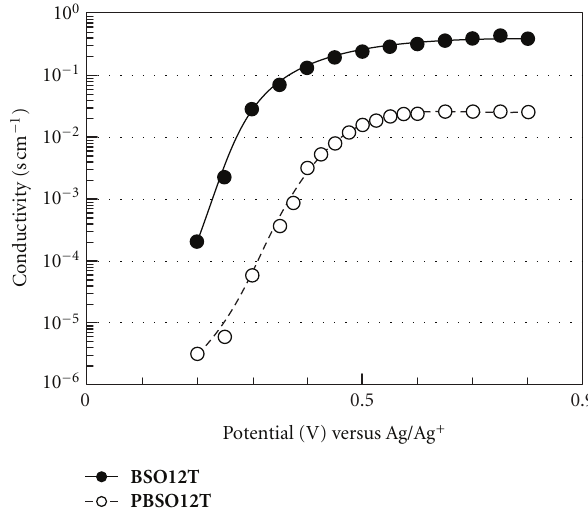
Figure 10: Doping levels plotted against electrode potential for (cid:2) : BSO12T and (cid:4) : PBSO12T films.